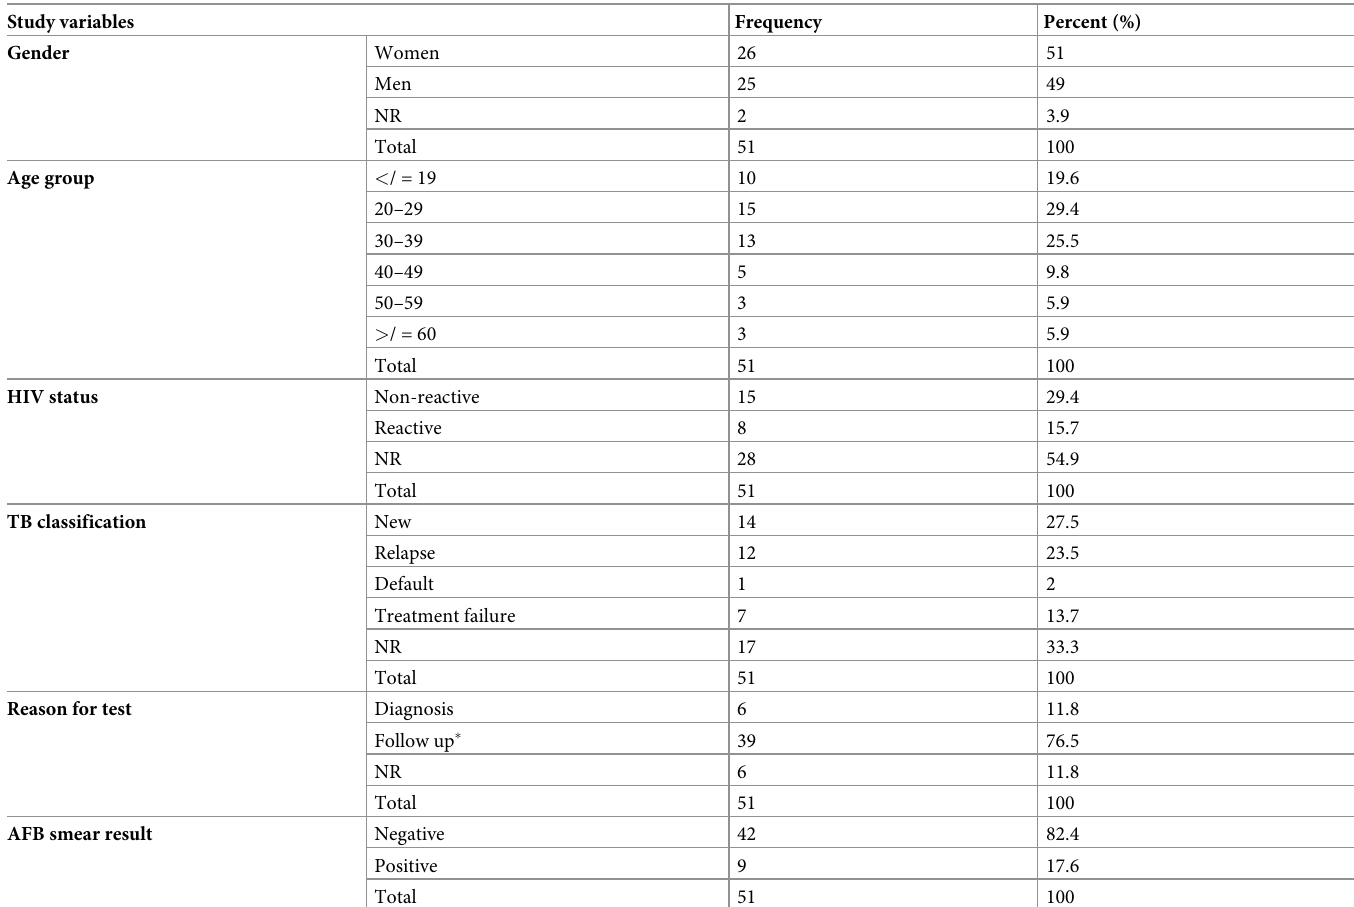
Table 1. Frequency distribution NTM isolation among PTB patients at EPHI Ethiopia.